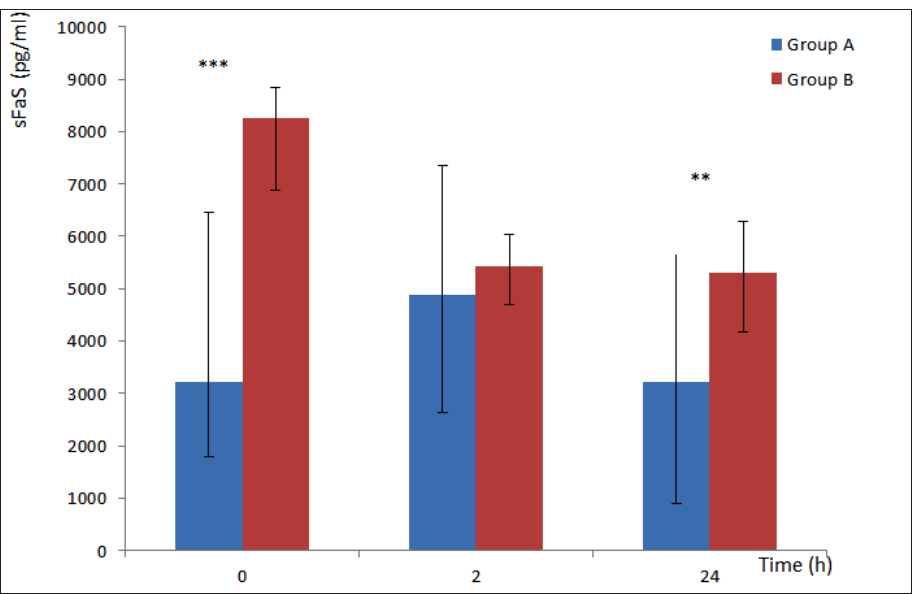
Fig. 1. The development of pleural fluid in Groups A and B. *** P <0.001, ** P <0.01, Ad-admission, D - discharge